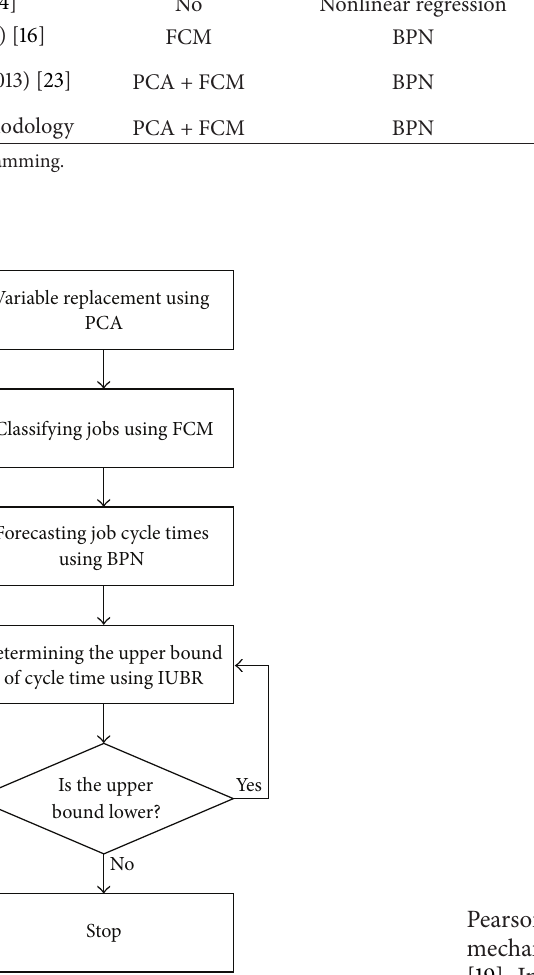
Figure 1: The flowchart of the proposed methodology.